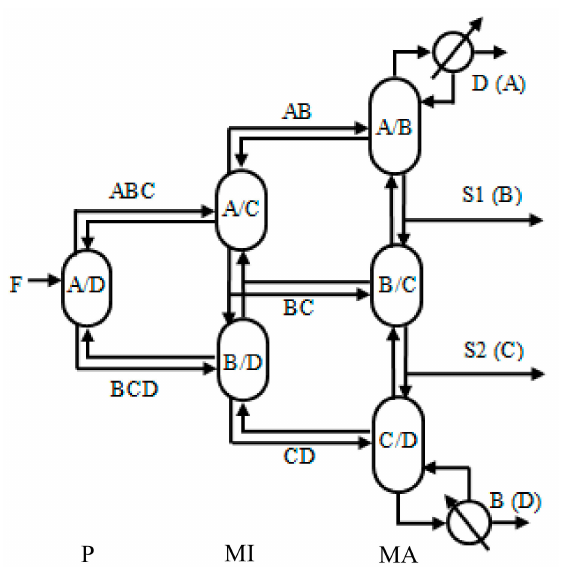
Figure 2. Thermally coupled structure of the extended Petlyuk DWDC.